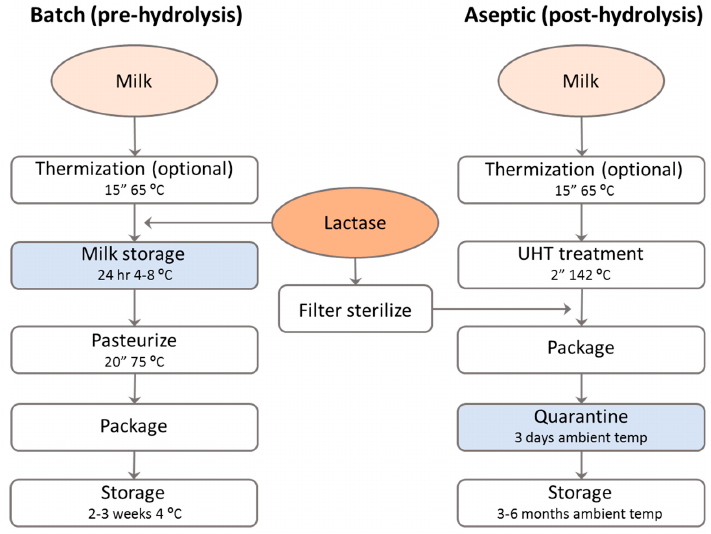
Figure 2. A schematic representation of the batch (left) and aseptic (right) processes that are used to produce lactose-free milk. The process conditions may vary from one factory to another, and additional process steps (like homogenization and standardization) are commonly included before the heat treatment. The batch process may include UHT treatment. The process step where lactose hydrolysis takes place is indicated in